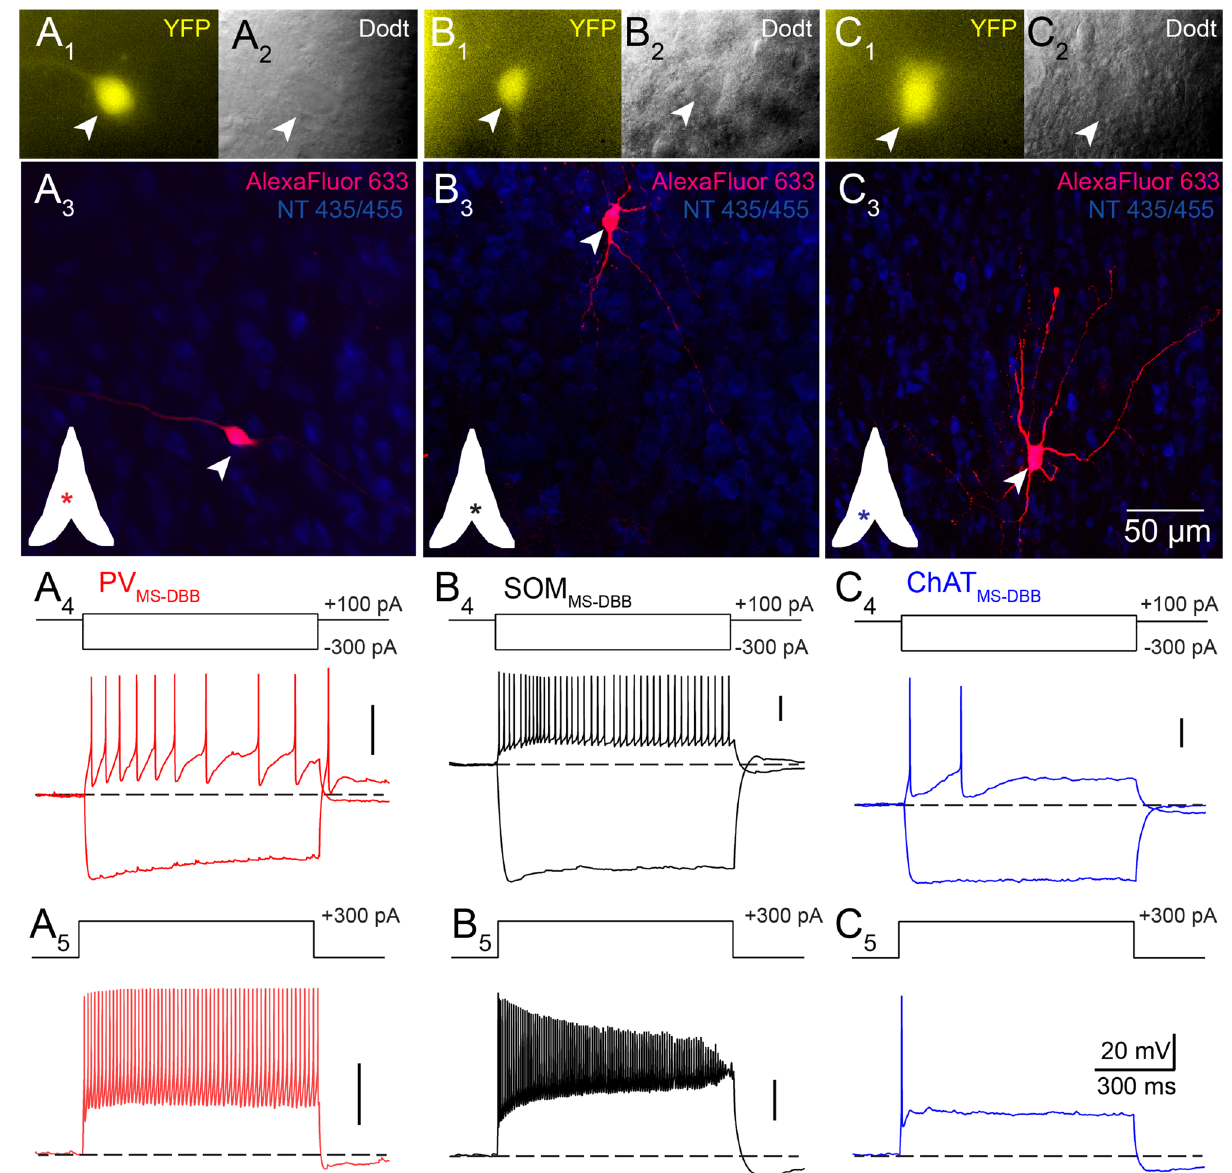
Figure 1. Passive and active properties of PV MS-DBB , SOM MS-DBB and ChAT MS-DBB neurons. Images of ( A1 ) live YFP, ( A2 ) live IR-Dodt contrast, and ( A3 ) flat-projected confocal stack of the representative PV MS-DBB neuron in ( A1 )–( A2 ) after post-hoc recovery of intracellular biocytin labeling. Inset depicts the cell location (asterisk) within MS-DBB. ( A4 ) Voltage responses to −300 and +100 pA and ( A5 ) +300 pA currents illustrate the fast-spiking phenotype of the PV MS-DBB and hyperpolarization-induced sag accompanied by a rebound spike. The PV MS-DBB neuron was maintained at −60 mV with the introduction of negative bias current. Representative ( B ) SOM MS-DBB and ( C ) ChAT MS-DBB neurons, formatted similarly to ( A ), exhibit differences in intrinsic